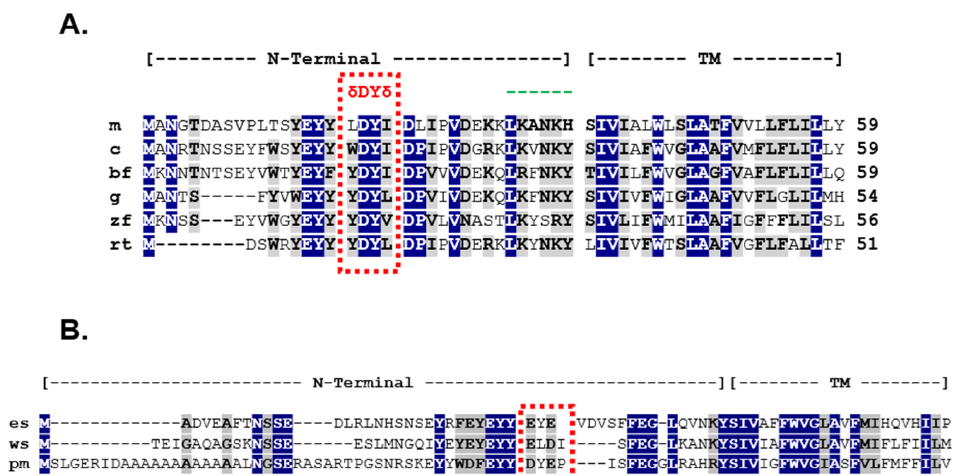
Figure 6. Multiple amino acid sequence alignment of vertebrate Mrap orthologs. ( A ) The amino acid sequence of N-terminal and transmembrane domains of mouse (m) Mrap1 (Accession No. NP_084120) chicken (c) MRAP1 (XR_001470382), bowfin (bf) Mrap1 (LOC: AMCT00016091, [17]), zebrafish (zf) Mrap1 (XP_001342923), and rainbow trout (rt) Mrap [accession number FR837908] were aligned and primary sequence identity (highlighted blue) and primary sequence similarity (highlighted gray) were determined using BLOSUM (https://www.ncbi.nlm.nih.gov/Class/FieldGuide/BLOSUM62.txt) ac- cessed on 6 August 2022. ( B ) The amino acid sequence of the N-terminal and transmembrane domains of elephant shark (es) Mrap1 (XM_007903550.1), whale shark (ws) Mrap1 (XP_020375601), and sea lamprey, Petromyzon marinus (pm) Mrap2 (BR000864.1) were aligned and analyzed as described